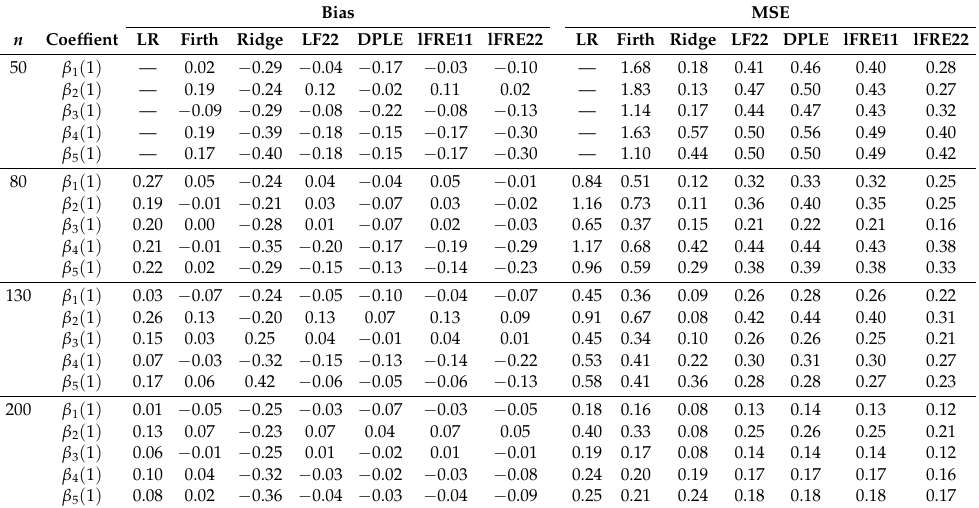
Table 2. Bias and MSEs of all explanatory variables (omitting the intercept) for sample size n ∈ { 50,80,130,200 } and a fixed correlation coefficient r = 0.85. Bias MSE n Coeffient LR Firth Ridge LF22 DPLE lFRE11 lFRE22 LR Firth Ridge LF22 DPLE lFRE11